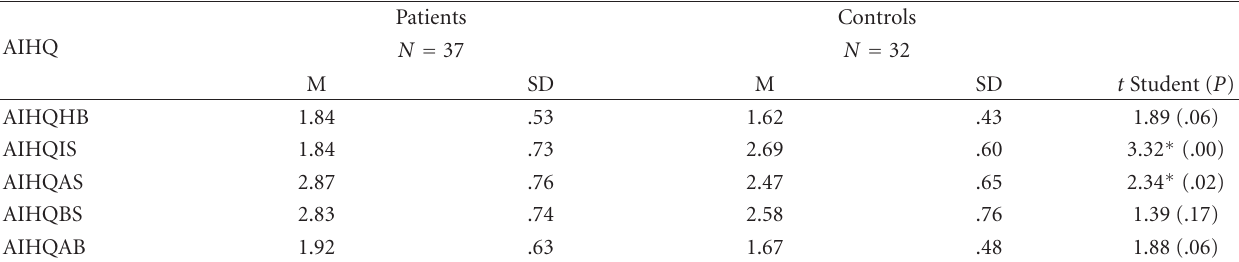
Table 2: Scores in the AIHQ subscales of the bipolar patients and healthy controls. AIHQ